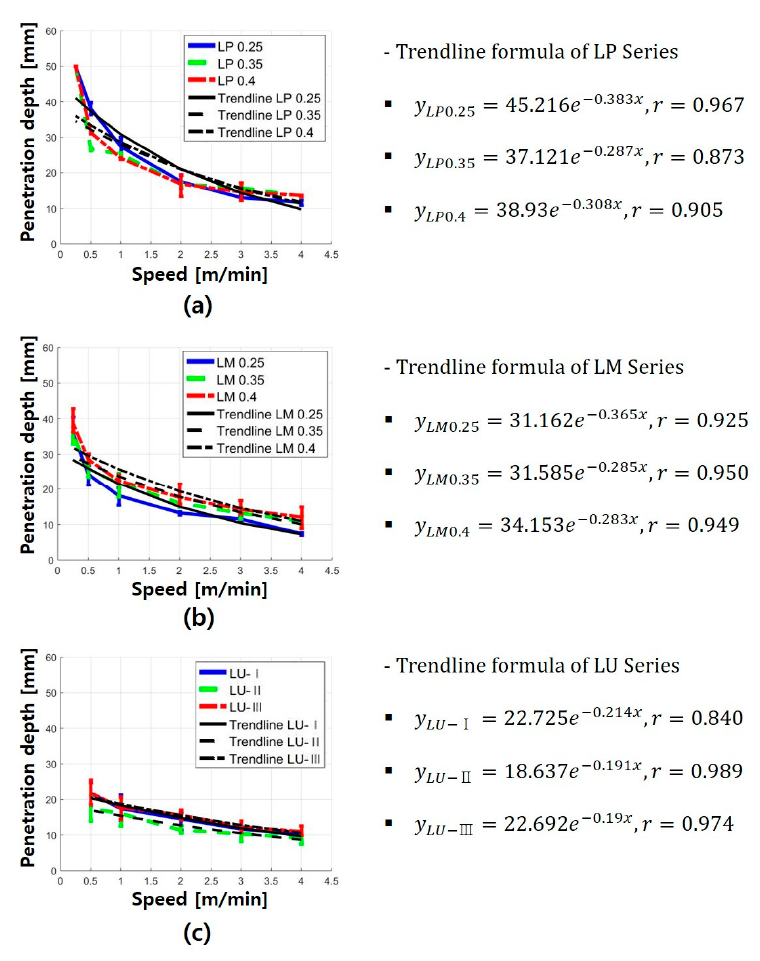
Figure 8. Average penetration depth graph and regression formula of ( a ) LP series, ( b ) LM series, and ( c ) LU series.